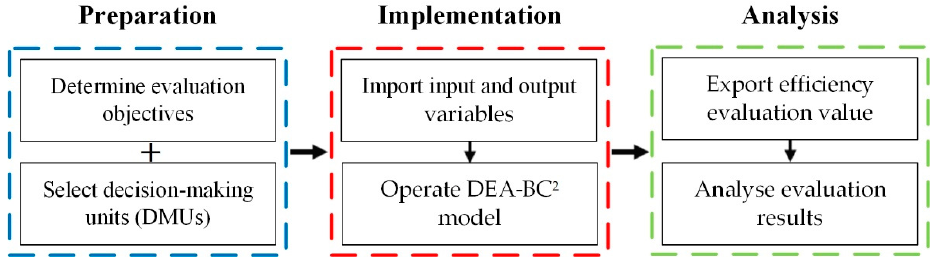
Figure 1. DEA model implementation process.